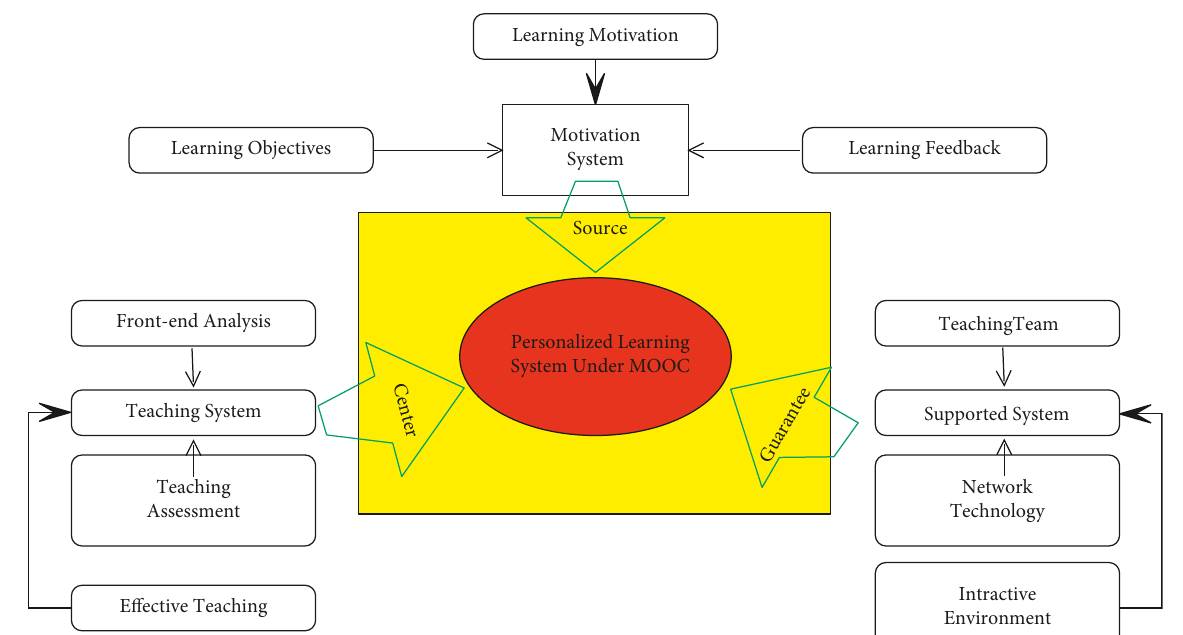
Figure 7: Personalized learning system in MOOC environment.